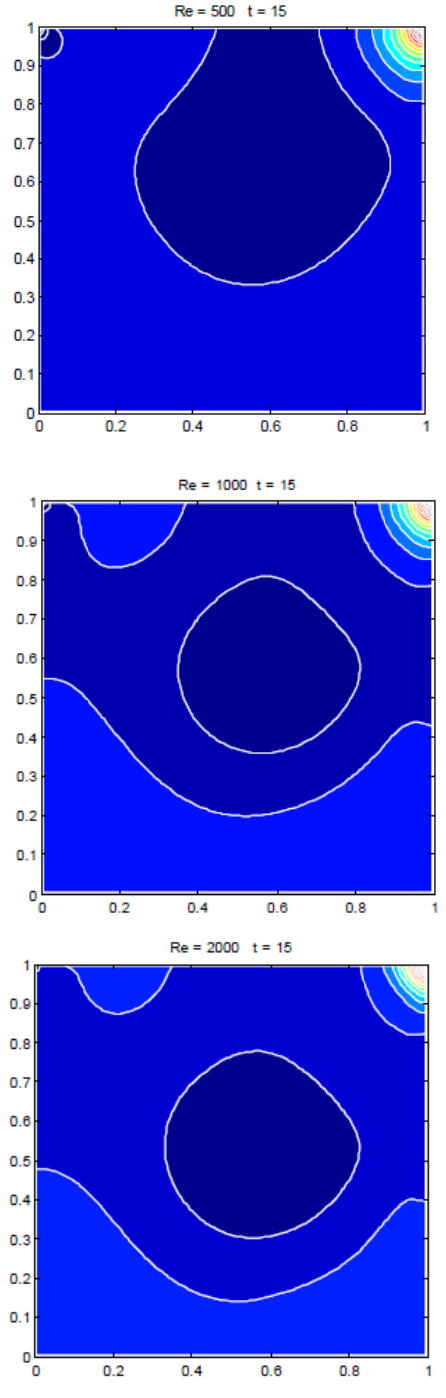
Figure 6. Pressure at t =15 sec for different values of